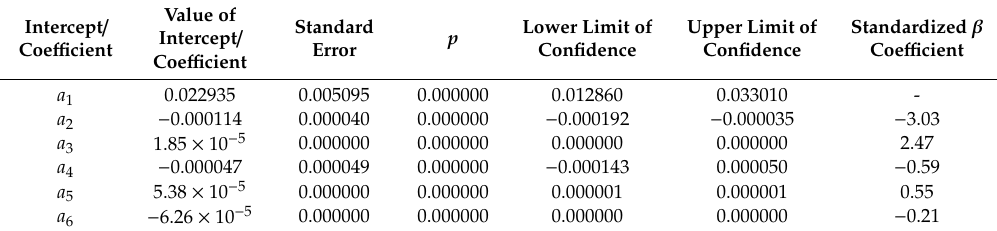
Table 15. Statistical evaluation of O:C ratio model of torrefied pruned biomass.